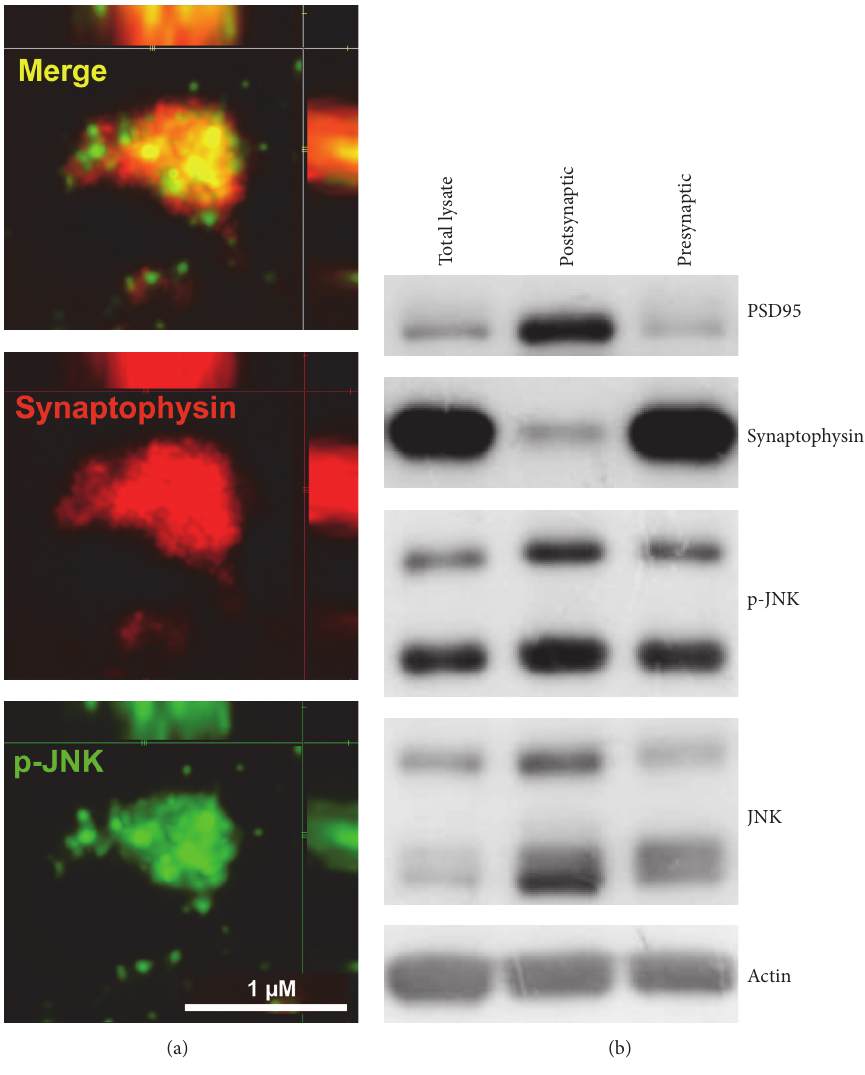
Figure 1: JNK is localized in the presynaptic compartment. (a) Immunofluorescence on mouse cortical purified synaptosomes stained for p- JNK (green) and for Syntaxin-2 (red) colocalization is visualized as yellow signal in Merge image, with Pearson’s coefficient 0.54 ± 0.08. Images acquired with super resolution microscopy; scale bar 1 𝜇 m. (b) Western blotting analysis of JNK and p-JNK active form presence in 20 𝜇 g of total cortical lysates, postsynaptic density region (represented by PSD95 postsynaptic specific protein on TIF fraction) and presynaptic compartment (represented by Synaptophysin presynaptic specific protein on purified synaptosomes). JNK is localized both in postsynaptic and in presynaptic region and its phosphorylation state is comparable. Actin was used as loading